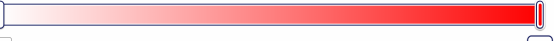
Figure 11. Difference enhancement model: Young-Elderly.